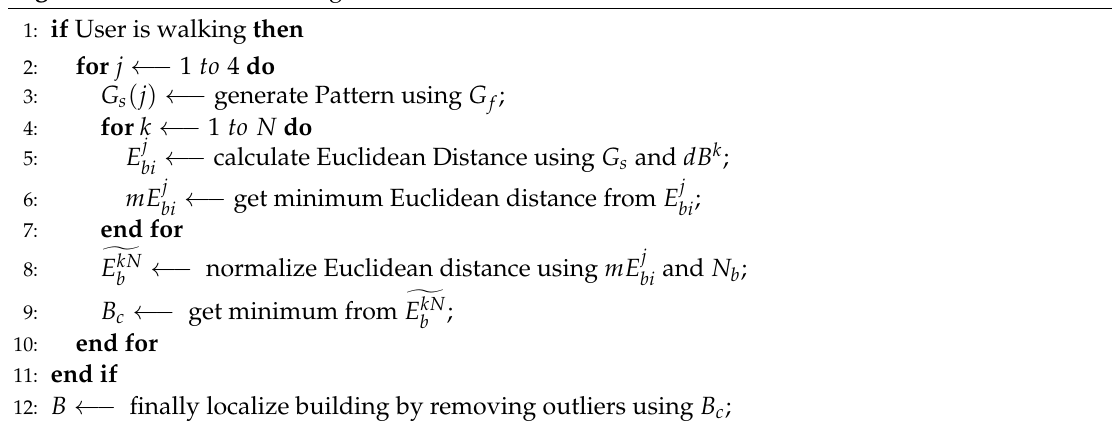
Algorithm 2 BLocate Building identification with sensors’